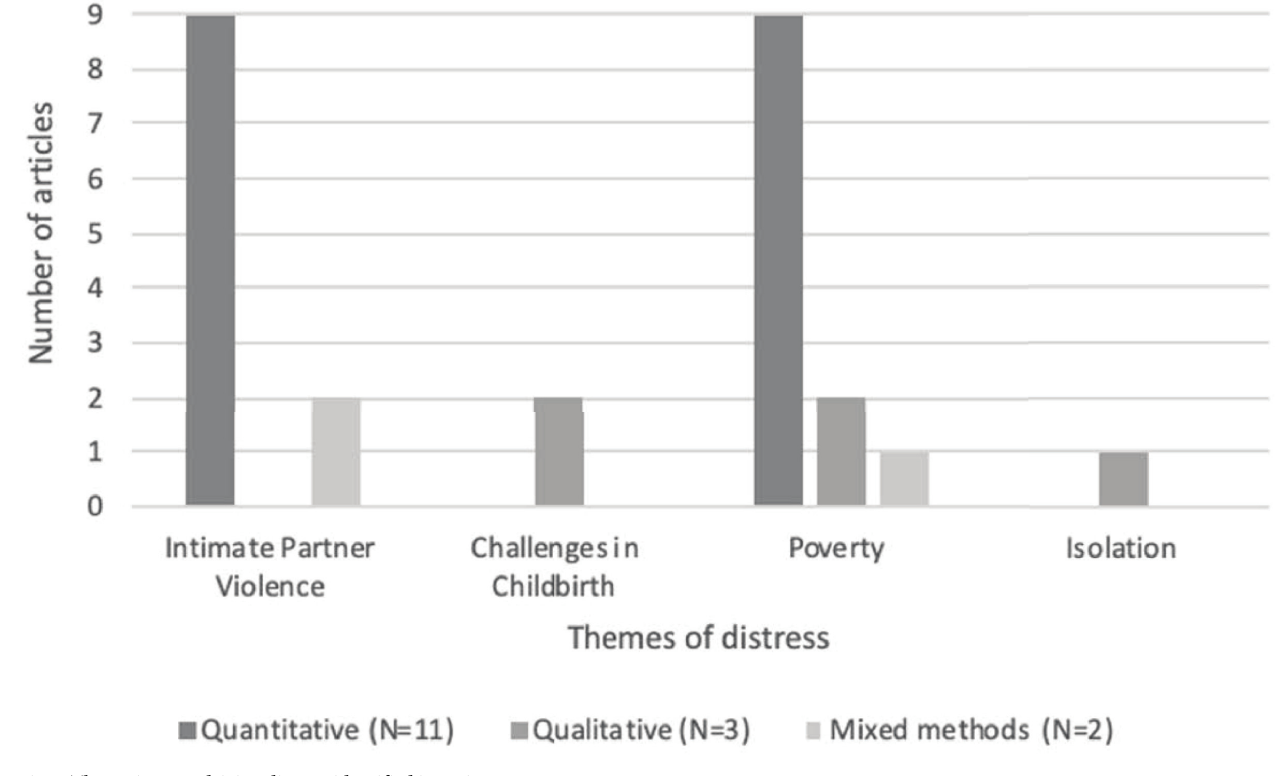
Fig 4. Thematic areas driving distress identified in review.